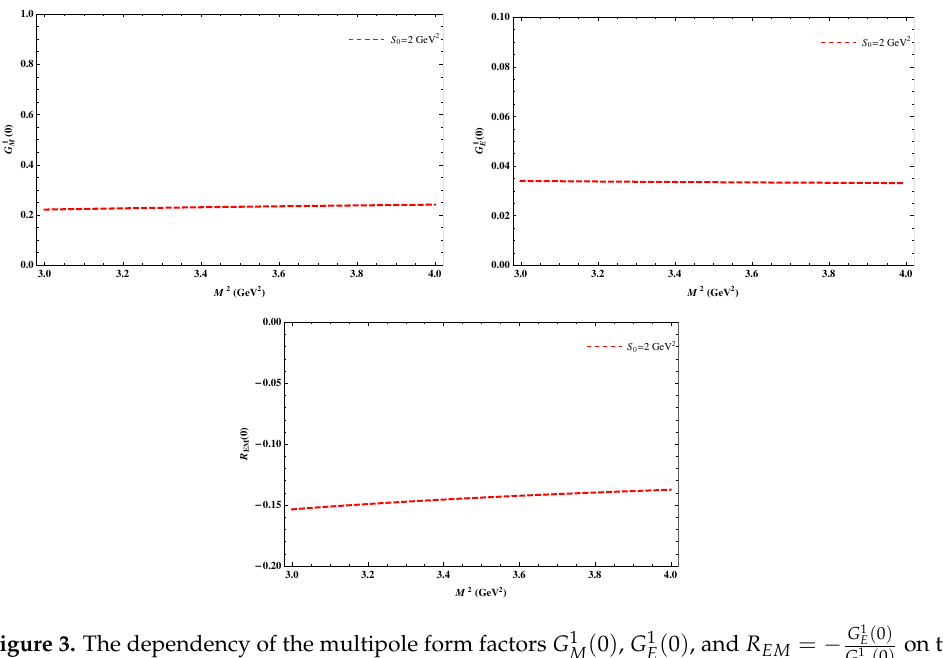
Figure 3. The dependency of the multipole form factors G 1 Borel mass parameter M 2 at fixed continuum threshold S 0